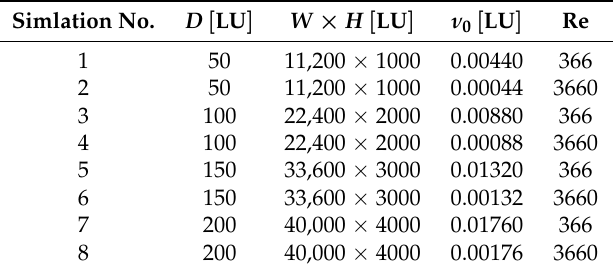
Table 3. Test matrix for sensitivity analysis at constant Fr = 0.4628. [ LU ] means that all the quantities are expressed in non-dimensional units characteristic of the LB framework. Simlation No.